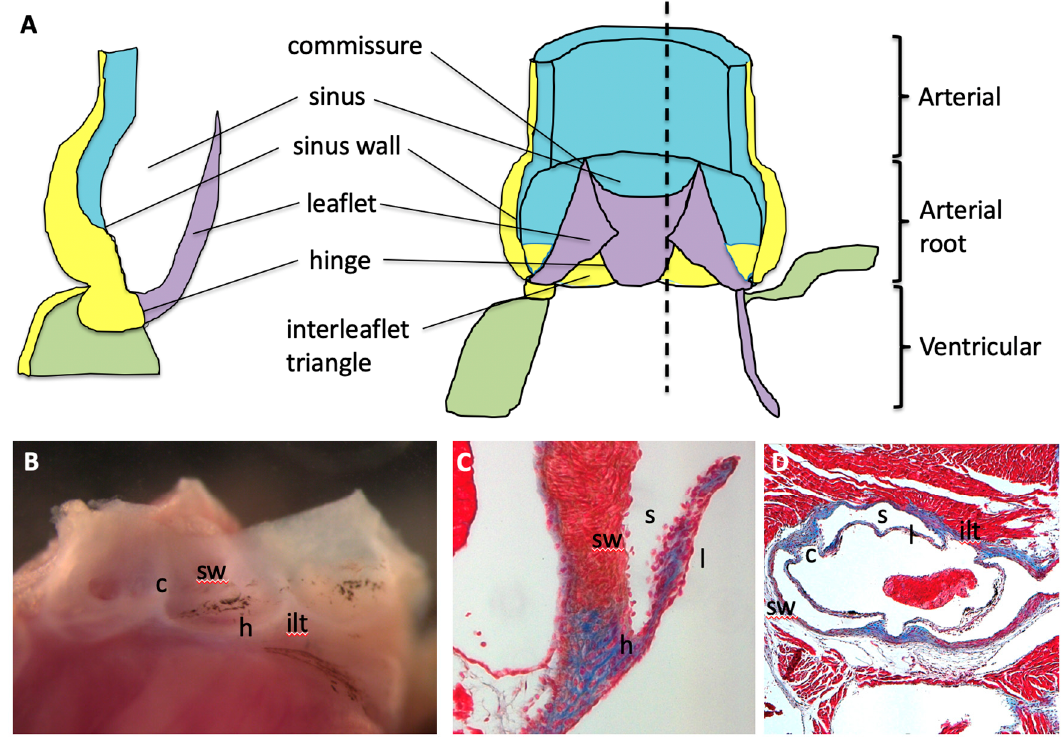
Figure 1. Anatomy of the arterial roots. ( A ) The arterial valve complex is made up of: three moving leaflets; the hinges, the attachment points of the leaflets to the wall; the commissures, the points of apposition of the leaflets close to the wall; the sinuses, pockets that form between the leaflets and the wall; and the interleaflet triangles, the regions of the wall that lie upstream (on the ventricular side) of the hinges, but are distal to the base of the sinuses that are found on the arterial side. Green = cardiomyocytes, blue = smooth muscle cells, yellow = fibrous tissue, purple = valve leaflet. The dotted line represents the position of the cross section through the valve complex. ( B ) Wholemount view of the adult mouse aortic root. The leaflets have been removed to allow the view of the other structures of the valve complex. ( C , D ) Masson’s trichrome images of the mouse aortic root at P21 in longitudinal and transverse planes. Red staining is muscle tissue, blue staining is fibrous tissue. c = commissure, h = hinge, ilt = interleaflet triangle, l = leaflet, s = sinus, sw = sinus wall.